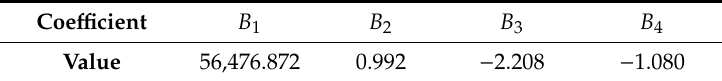
Table 4. Coe ffi cients in Equation (10).